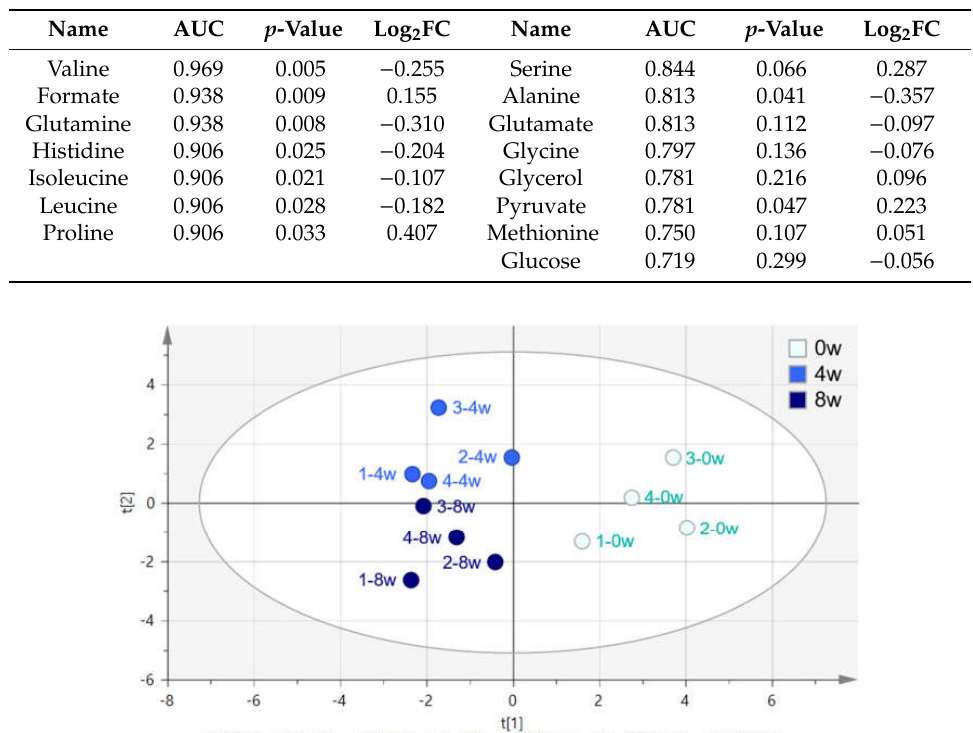
Table 2. Area under the curve (AUC) values of metabolites over 0.7 obtained from biomarker analysis of groups of before and after feeding of black ginseng.